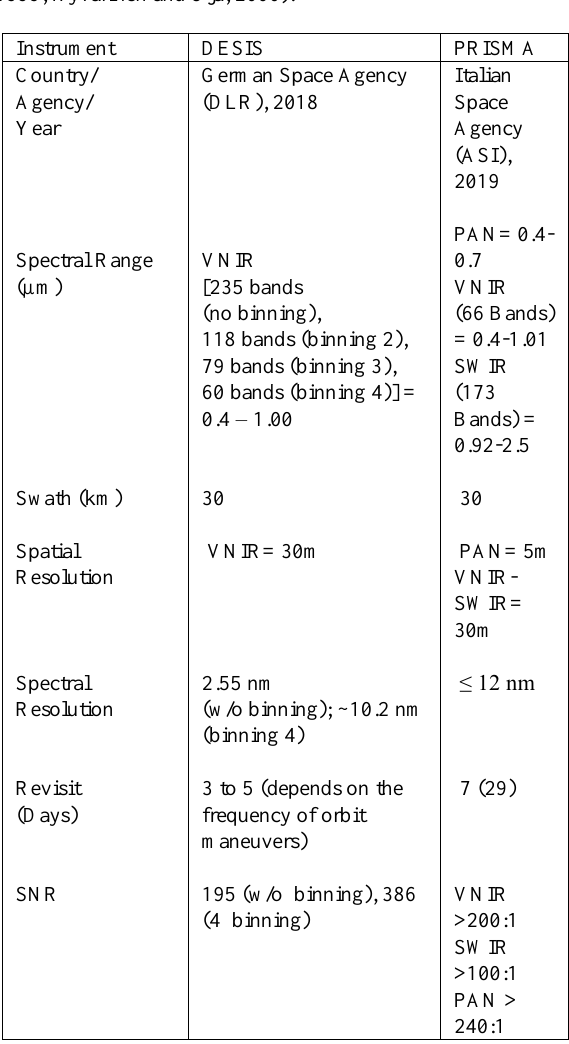
Table 1 . Specifications for DESIS and PRISMA datasets